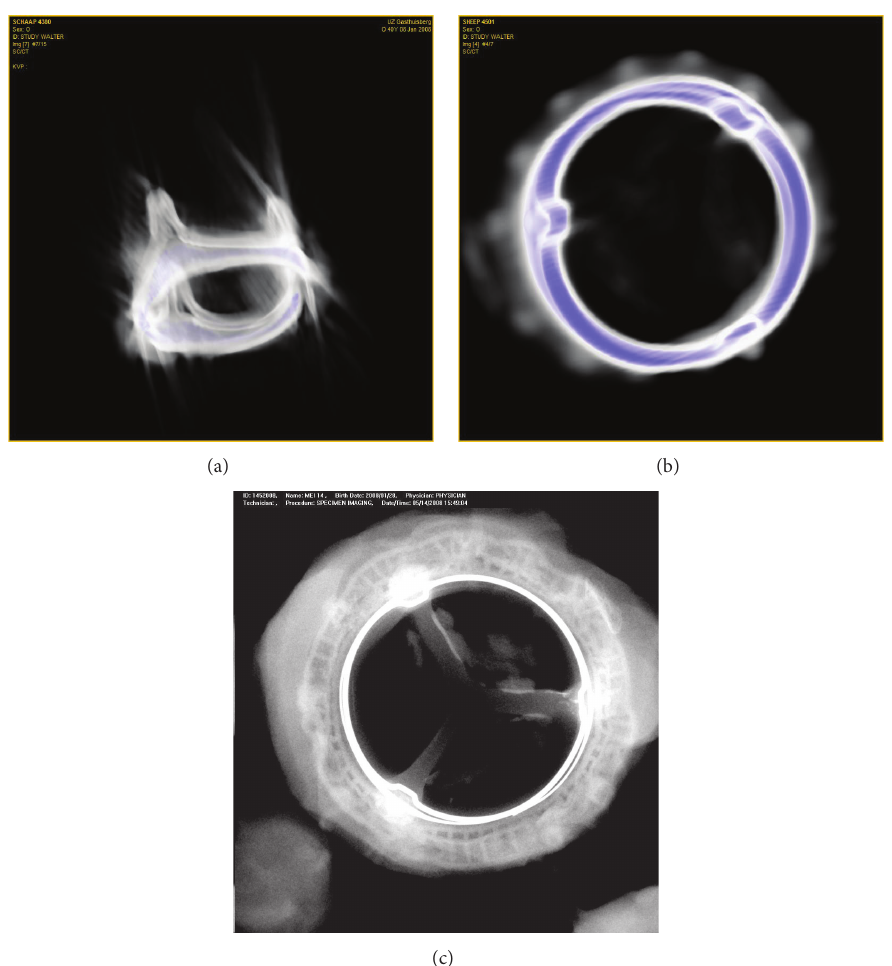
Figure 2: (a) shows a reconstructed image from a scan performed in the mitral model. The alloy frame of the valve stent produces, probably due to its continuous motion, important scattering around the prosthesis. (b) illustrates how this scattering can be filtered, but through this process potential areas of mineralization within the cusps are also deleted. (c) shows the Faxitron X-ray image after explantation at 20 weeks, illustrating that there is clear calcification within two of the commissural